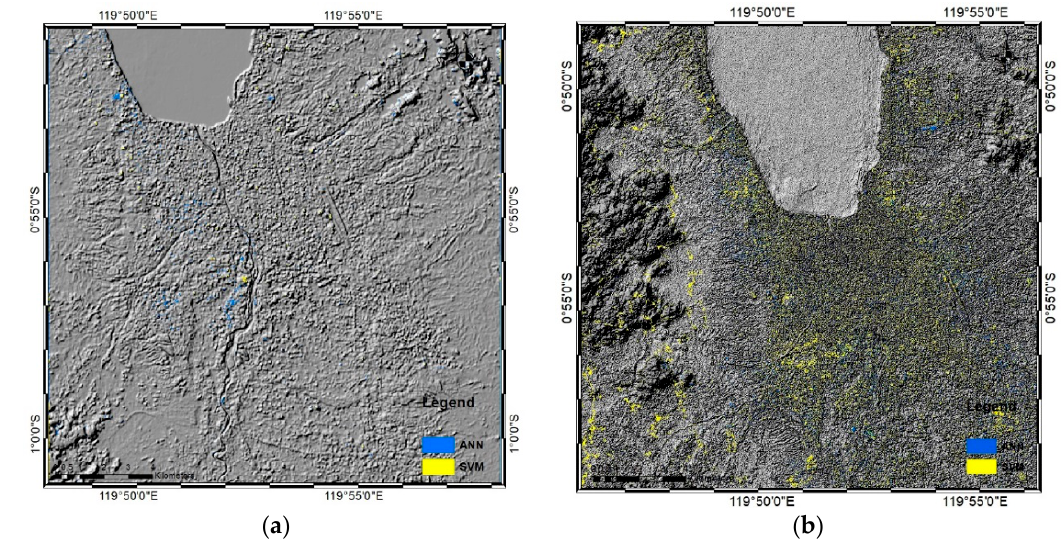
Figure 12. Decorrelation maps showing the differences between ( a ) the Landsat-8 ANN and SVM results for the post-earthquake damage area and ( b ) the Sentinel-2 ANN and SVM results for the post-earthquake damage area in hillshade view.